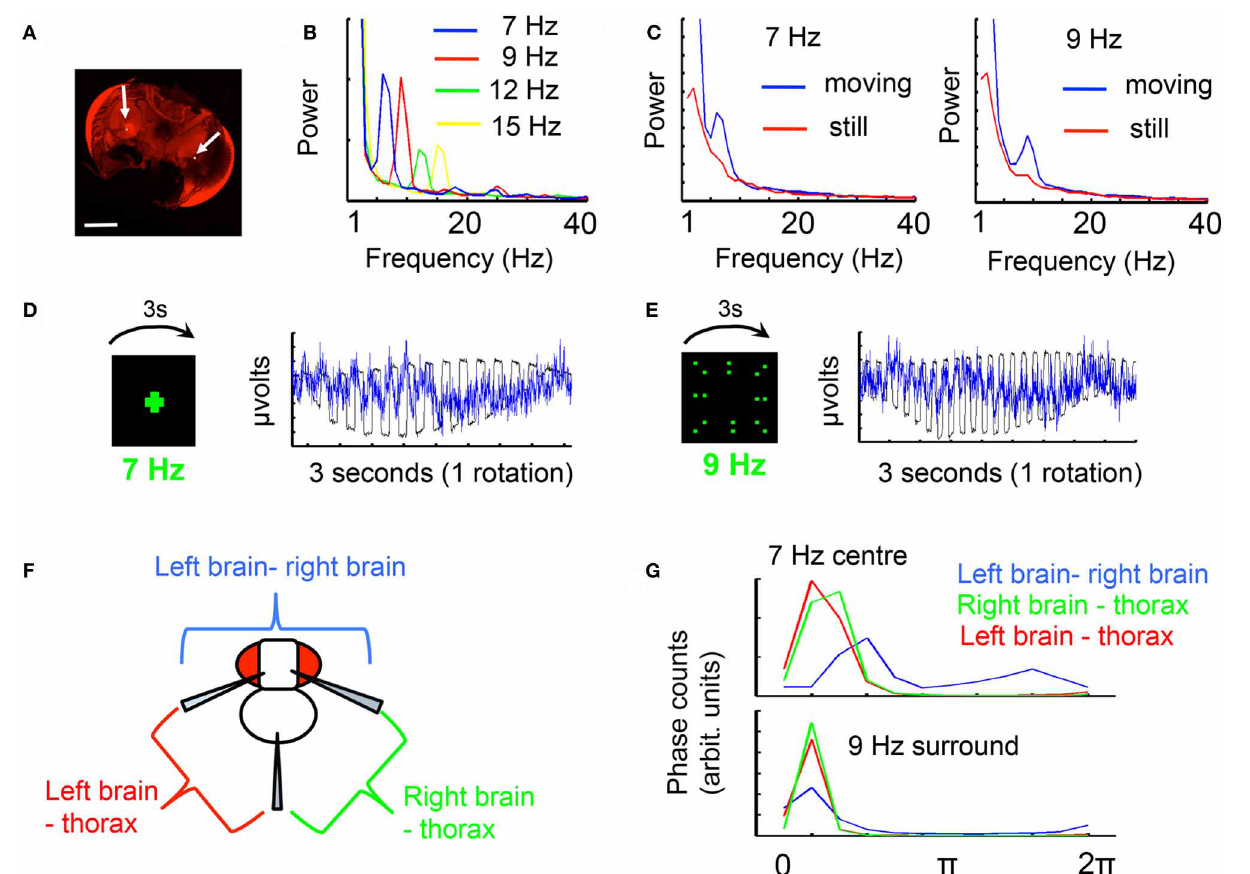
FIGURE A1 | The frequency tag. (A) Recording sites in the Drosophila brain (arrows). Texas Red dye was released from glass recording electrodes by iontophoresis, and the two recording sites determined by the region with greatest staining intensity, in the inner optic lobe. A differential recording was made between these sites. Inset scale bar = 100 µ m. (B) A moving object (a cross moving 120 ◦ /s) flickering at different frequencies evokes distinct frequency responses in the recorded brain LFP, shown here for four different frequency tags. (C) A moving flickering object (a cross moving 120 ◦ /s) evokes a greater frequency response in the brain LFP than a static flickering object (positioned 45 ◦ to the left of the front of the fly) for either 7 or 9Hz. (D) The LFP tag (blue trace) is time-locked to a cross flickering at 7Hz